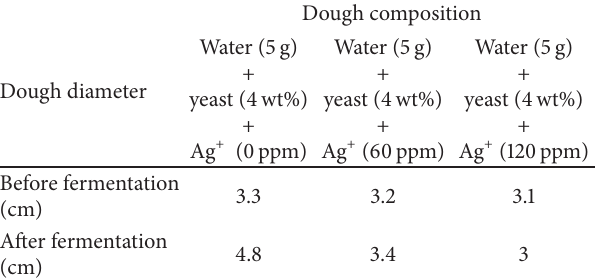
Table 2: Experimental result of antibioactivity effect of Ag +